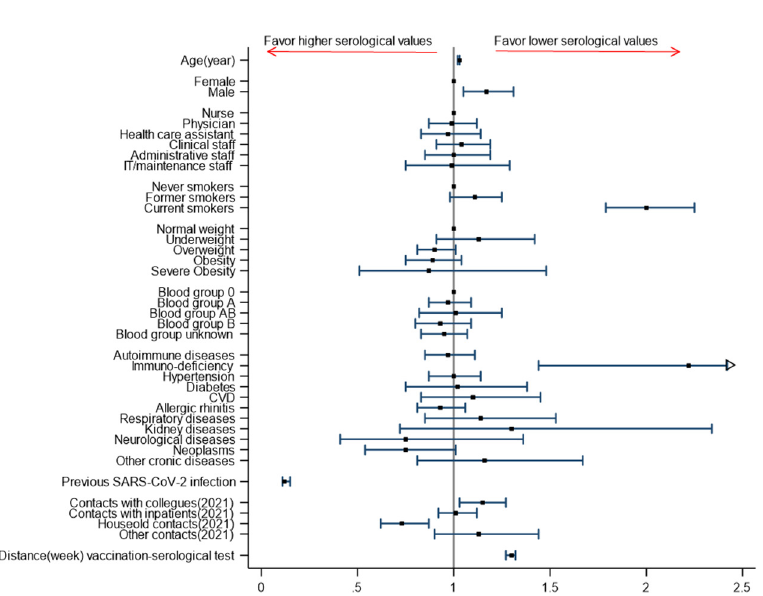
Figure 1. Results of multivariable ordinal logistic regression model (ORs and 95% CI) for predictors of lower serological values (quintiles of distribution) among vaccinated HCW of CSS.